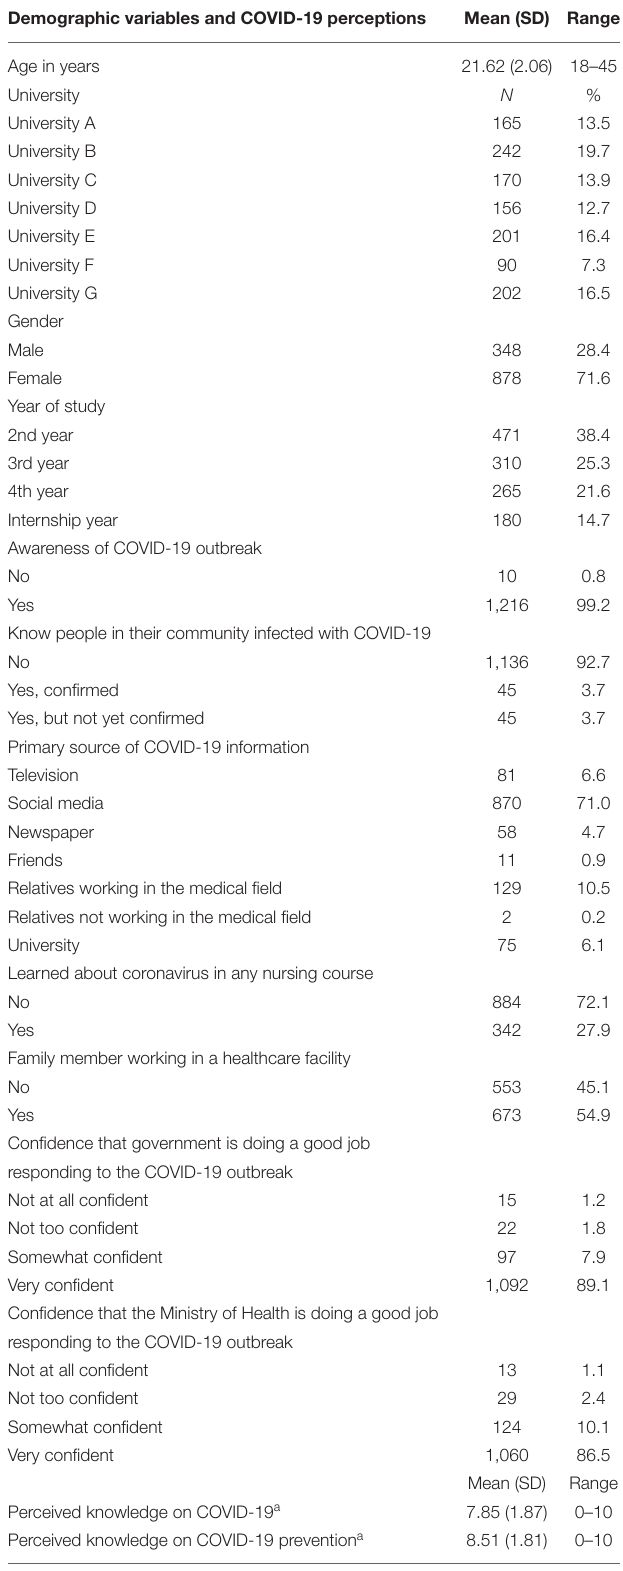
TABLE 1 | The demographic characteristic and perceptions related to COVID-19 among the Saudi nursing students ( n = 1,226). Demographic variables and COVID-19